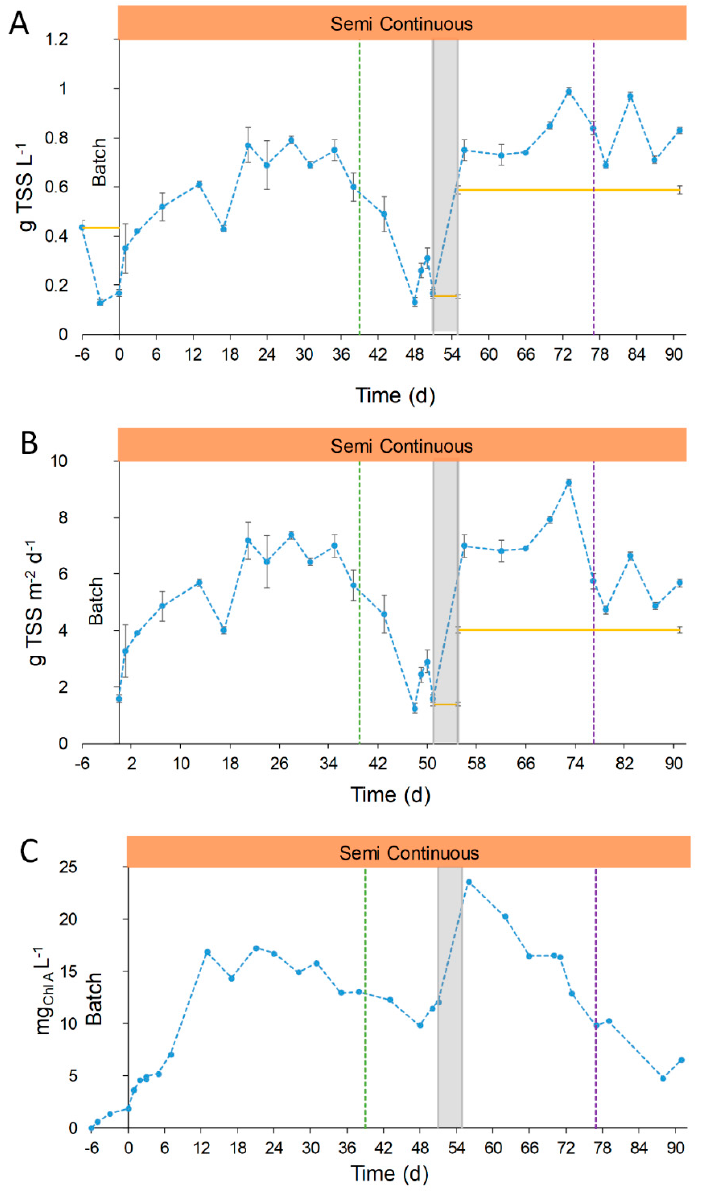
Figure 4 . Evolution of biomass during raceway operation. Total suspended solids (TSS) concentration ( A ), areal productivity ( B ) and chlorophyll concentration ( C ). Blue dotted line represents the concentration in the effluent ( ●●● ) and the continuous yellow line represents the concentration in the influent ( ̶ ) . Semi-continuous operation is represented in orange, , and the transition stage in grey, . Green dotted line ( ●●● ) represents the change in the feeding mode. Violet dotted line ( ●●● ) represents the shift in the column depth.